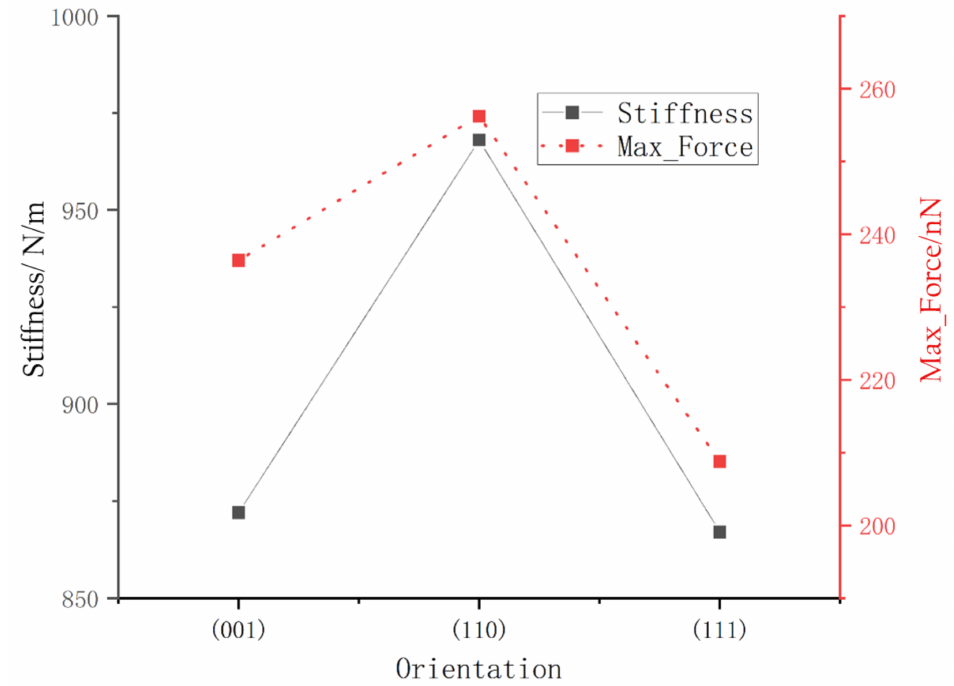
Figure 7. The maximum load and rigidity of the three crystal